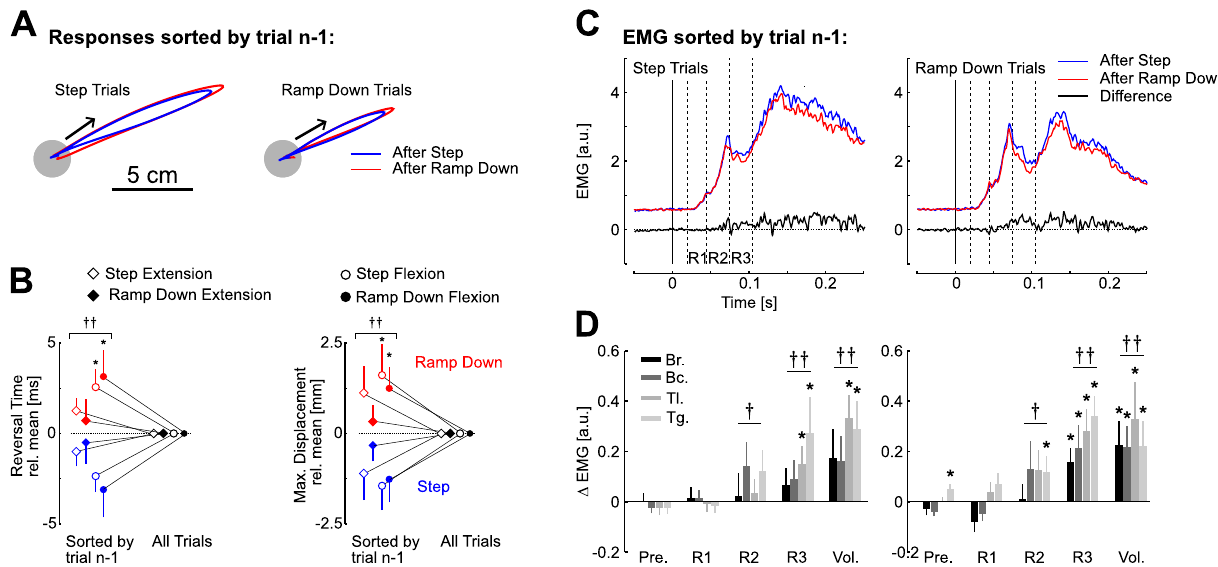
Figure 7. Results of experiment 2. A: Average hand path from one representative subject following step torques and ramp-down torques sorted by trial n-1. The blue traces are the average across all trials preceded by a step perturbation and the red traces are the average across all trials preceded by a ramp-down perturbation. B: Trial-by-trial modulation of the corrective response depending on the preceding trial for step (open symbols) and ramp-down (filled symbols) flexion and extension perturbations (disk and diamond, respectively). Significant differences in data from single perturbation profile (*) and from all perturbation pooled together ( { ) are shown at the level P , 0.05 (one symbol) and P , 0.01 (two symbols). C: Grand average across the four muscles of interest and across subjects of trials sorted by trial n-1 with identical color code as in panel A for step torques (left) and ramp-down (right) torque profiles. The black traces are the differential signals between blue and red responses. The dashed vertical lines represent the different epochs of rapid motor responses (see Methods). D: Binned analysis of the difference in activation across responses preceded by step torques and responses preceded by ramp-down torques for the four muscles of interests following step perturbations (left) and ramp-down perturbations (right). As in panel C, positive designates an increased activity when the trial is preceded by a step perturbation. Bars represent one standard error across the 12 subjects. From dark gray to light gray, displays are Brachioradialis (Br.), Biceps (Bc.), Triceps Lateralis (Tl.), and Triceps Long (Tg.). Stars indicate significant modulation of the corresponding muscle at the level P , 0.05 and the dagger ( { ) indicates significant modulation from all muscle samples pooled together (one symbol, P , 0.05; two symbols, P , 0.01).